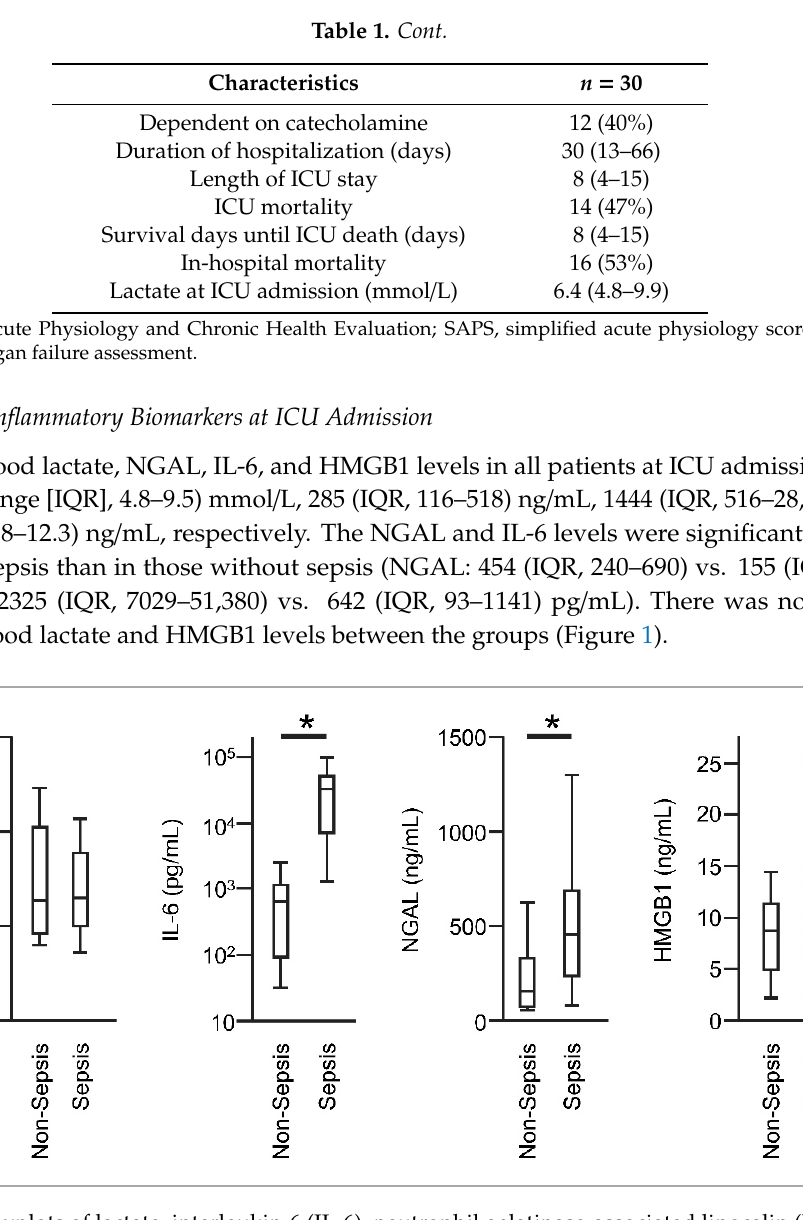
Figure 1. Boxplots of lactate, interleukin-6 (IL-6), neutrophil gelatinase-associated lipocalin